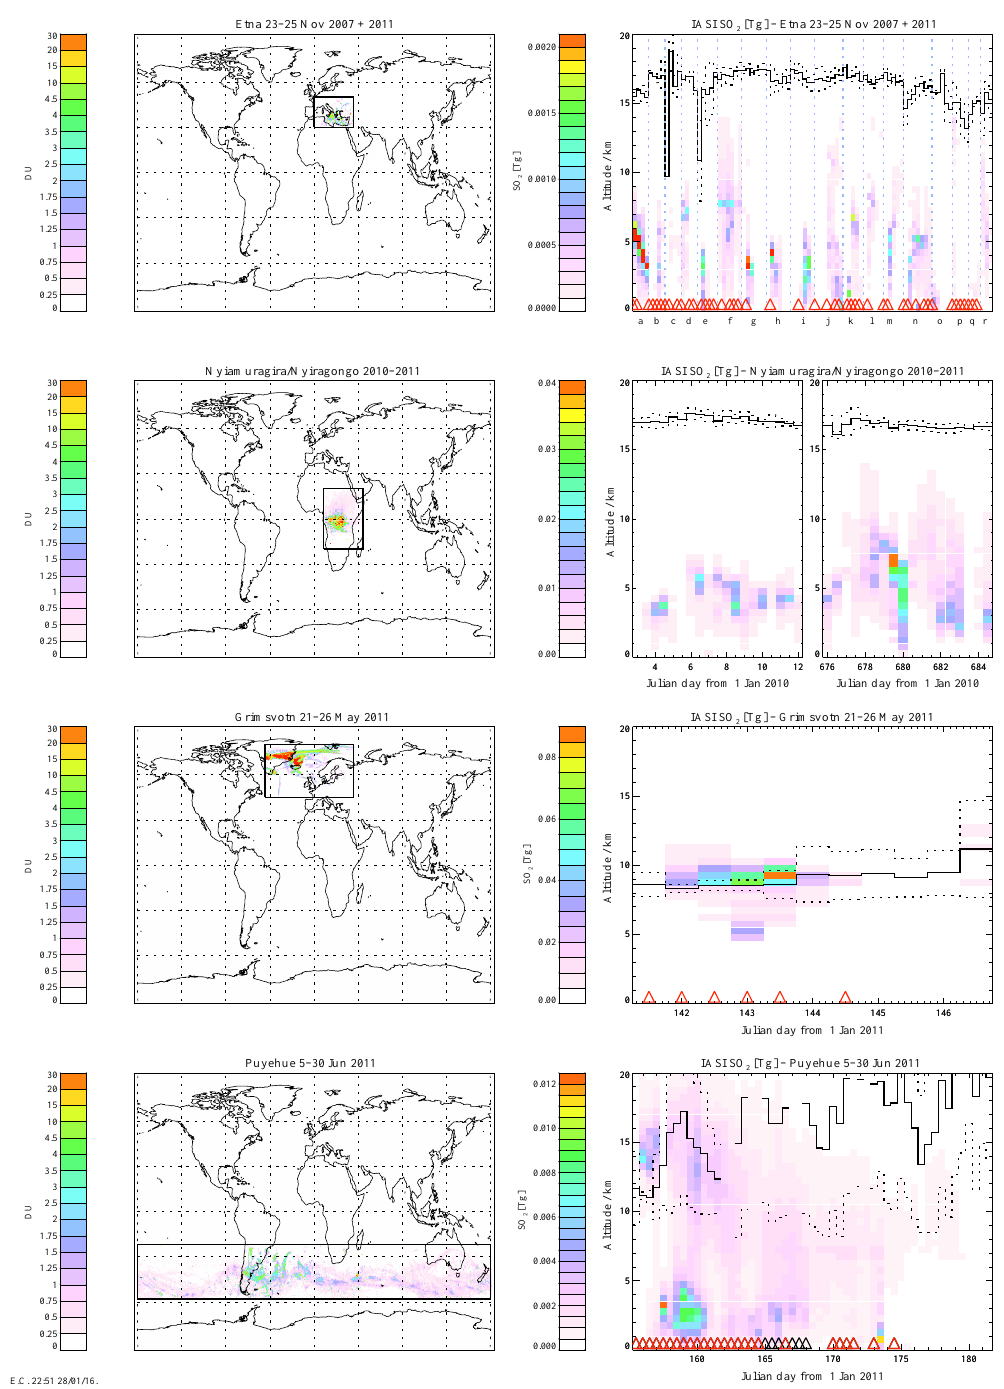
Figure 10. As for Fig. 8. The Etna plots show different eruptive episodes corresponding to x axes labels: (a) 23–25 November 2007 eruption; and the 2011 lava fountains: (b) 11–13 January, (c) 17–19 February, (d) 10–12 April, (e) 11–13 May, (f) 8–10 July, (g) 18–20 July, (h)